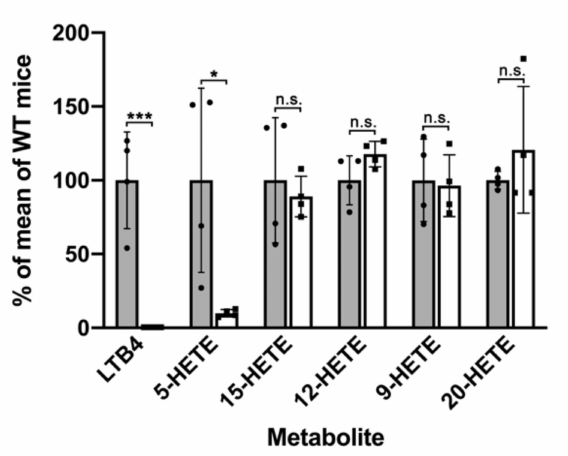
Figure 2. Alox5 ex vivo activity assays using whole blood. Alox5 -KI mice and corresponding outbred wildtype controls ( n = 4 of each genotype) were sacrificed under anesthesia and heparinized